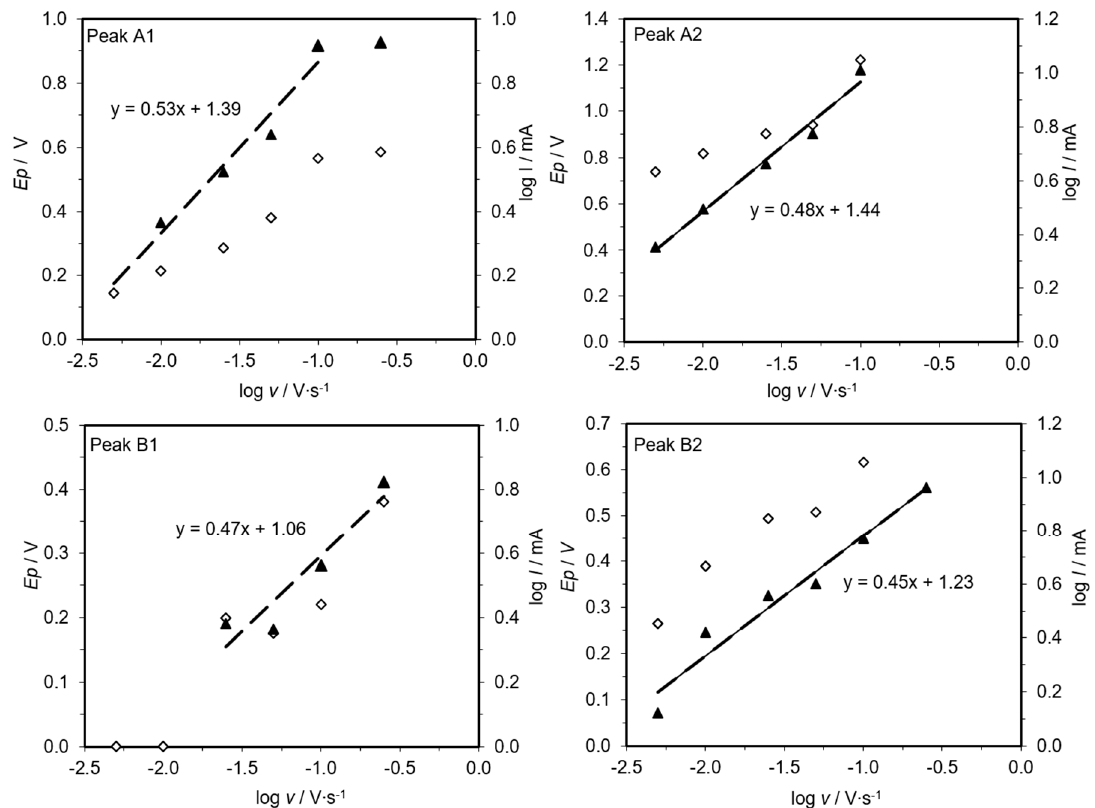
Figure 5. The log ( I /mA) vs. log ( v /V ∙ s -1 ) ( ▲ ) and Ep vs . log ( v /V ∙ s -1 ) ( ◊ ) curves for the distinguished oxidation peaks in the SMFC with the carbon Toray anode (peak A1 and peak A2) and with the stainless steel anode (peak B1 and peak B2).